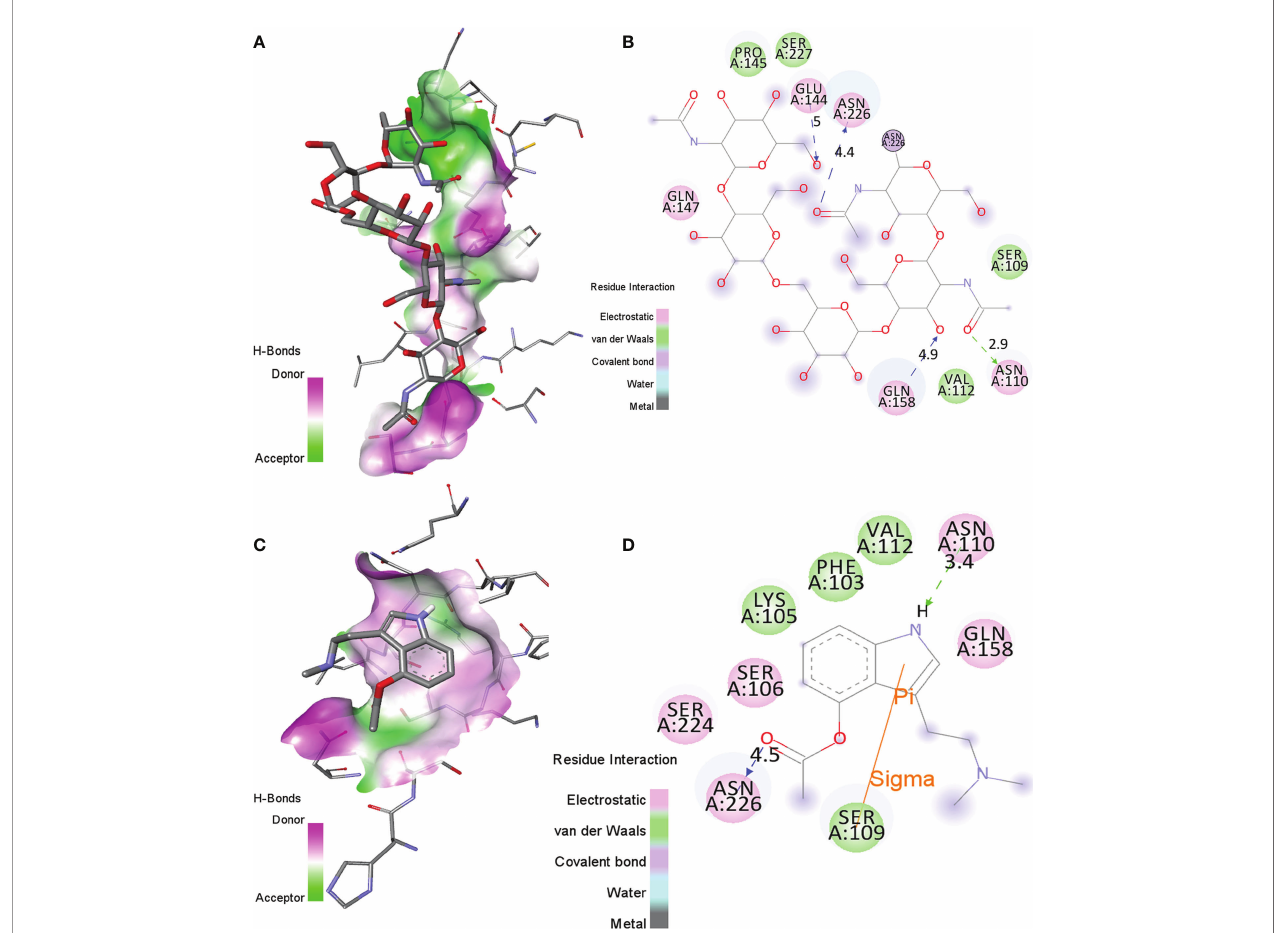
FIGURE 2 | (A, B) The molecular interactions of the Human Interleukin-6 receptor with its co-crystallized ligand in the active site. (C, D) The molecular contacts of psilacetin with HIK-6.